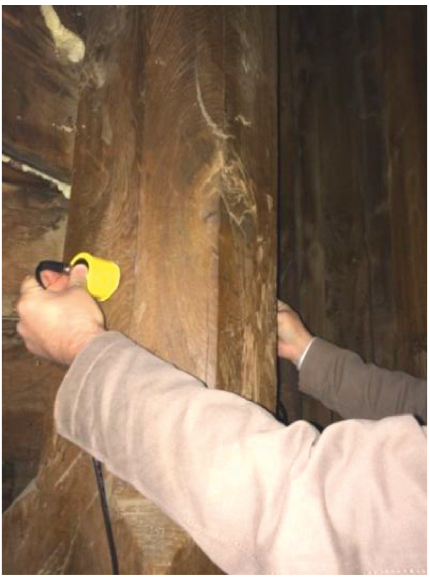
Figure 5: In situ ultrasonic test of timber core (the direct method). Table 6: The material properties of the timber elements used in the construction of minarets.